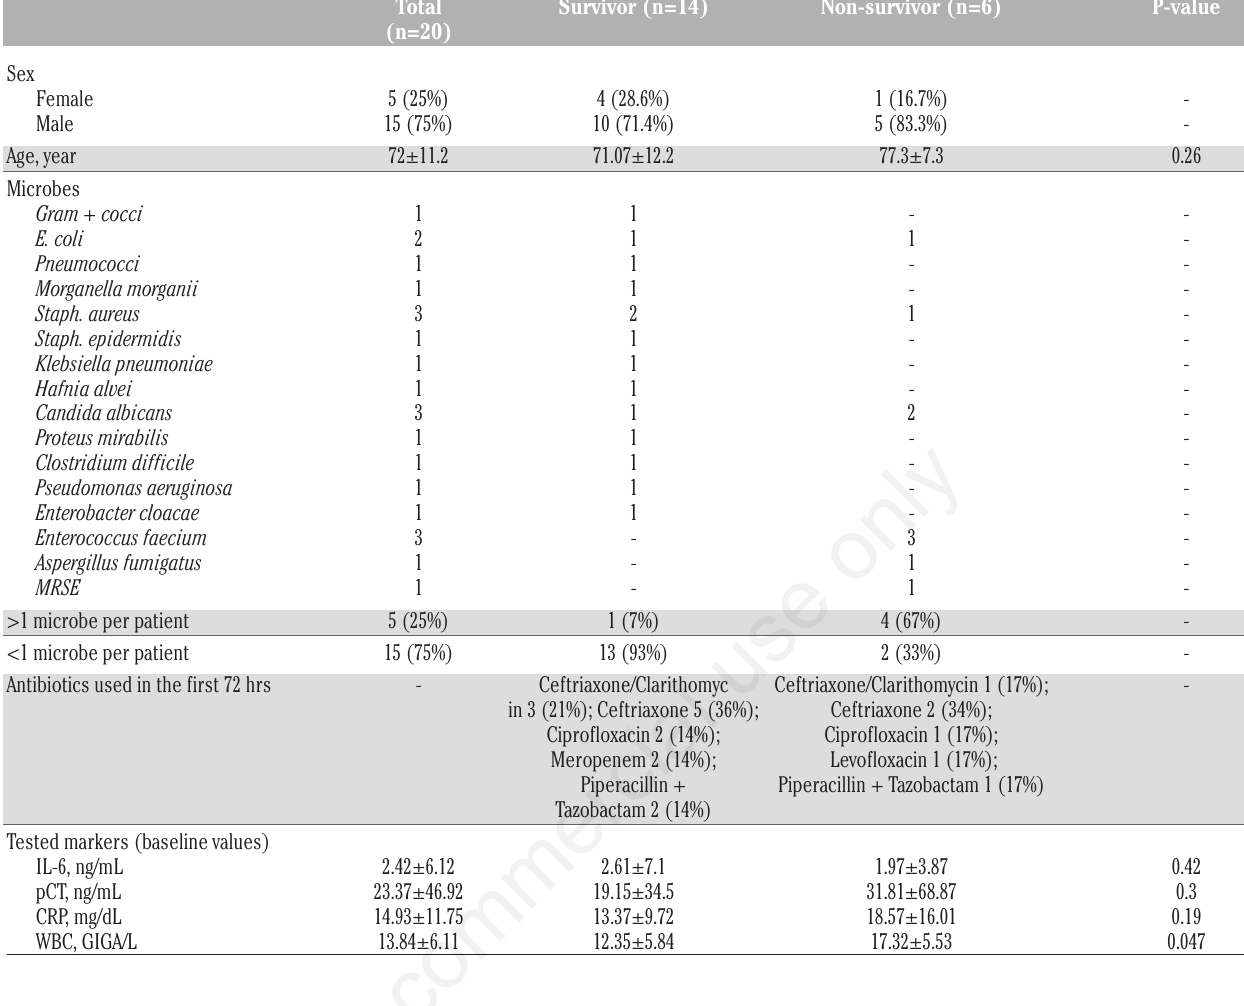
Table 1. Characteristics of patients and etiological organisms. All patients were diagnosed with severe bacterial sepsis or septic shock according to the criteria of Angus and van der Poll 2013. Mean baseline values for IL-6, CRP, PCT and WBC are summarized. A P<0.05 is considered as statistically significant